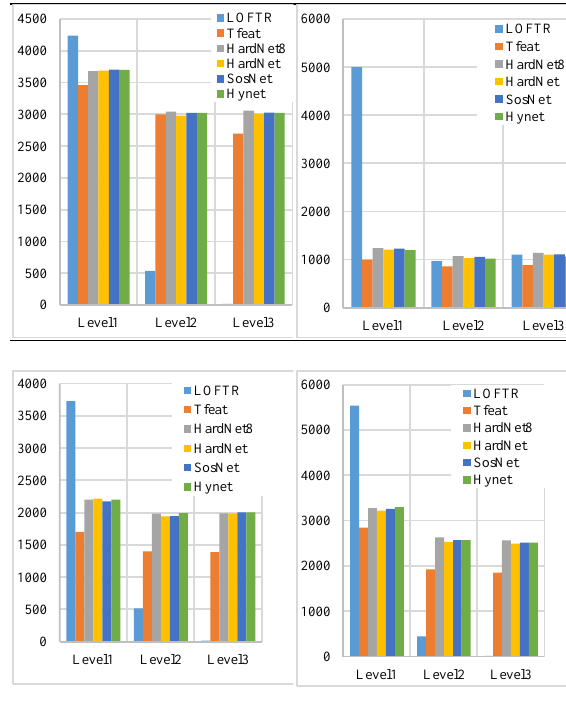
Figure 4. The number of identified inliers for the rotation test. The first row from left to right relate to cases a and b, and the second row from left to right relates to cases c and d, respectively. Figure 5. The precision values for the rotation test. the first row from left to right relates to cases a and b, and the second row from left to right relate to cases c and d, respectively As expected, assignment and applying the SIFT feature detector reveal rotation robustness effectively and prevent the matching